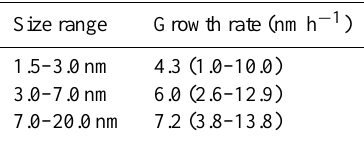
Table 1. Growth rates of particles during NPF events. The median values and the range from the 5th to 95th percentile are shown. The growth rates were determined from the positive ion size distribu- tions measured with the NAIS.